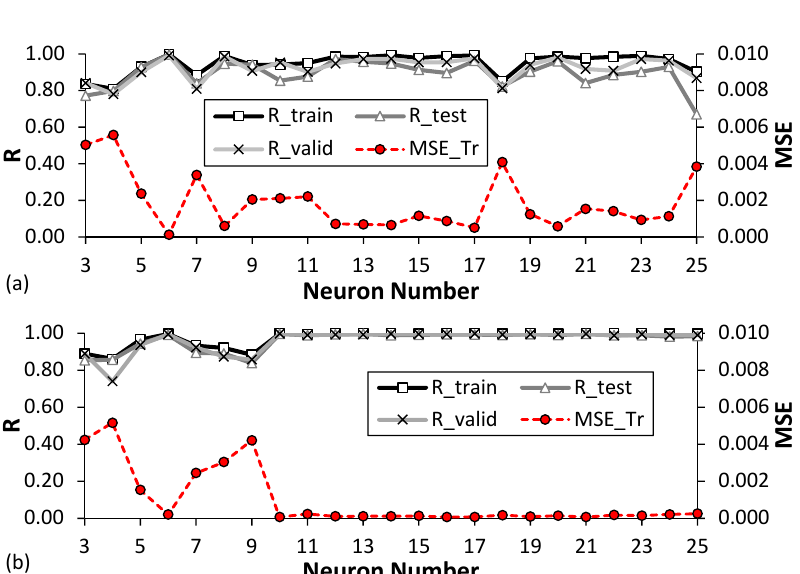
Figure 16. The R and MSE values at different neurons in hidden layer of ANN model: ( a ) β ; ( b ) α .